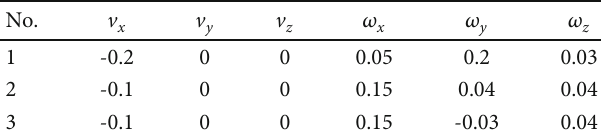
Table 4: Kinematics information of the unknown